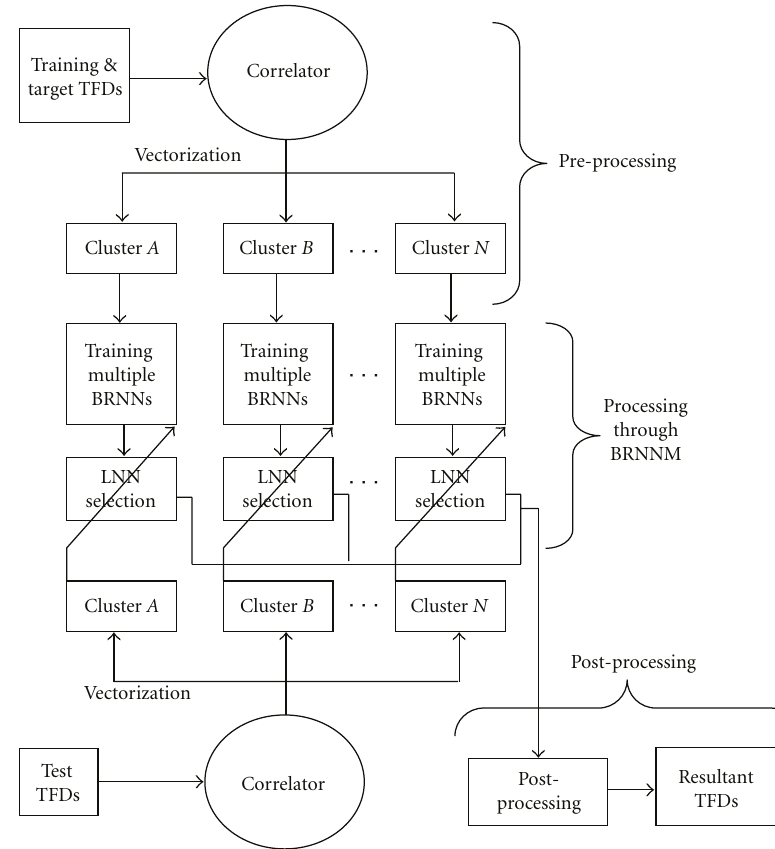
Figure 22: Flow diagram of the NN-based method